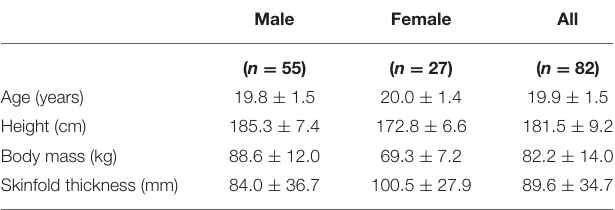
TABLE 1 | Physical characteristics of